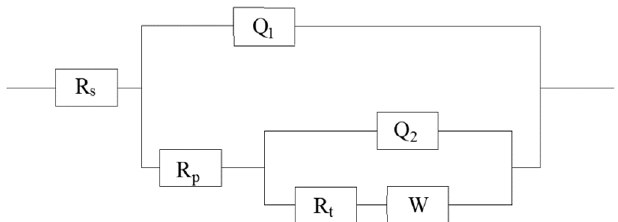
Figure 11. Equivalent analog circuit diagram of EIS under different filament currents ( R s , Corrosion solution resistance; R p , Corrosion product resistance of coating; Q 1 , Corrosion product capacitance of coating; R t , Charge transfer resistance; Q 2 , Double layer capacitance; W , Warburg resistance). Table 3. EIS equivalent circuit fitting results under different filament currents.